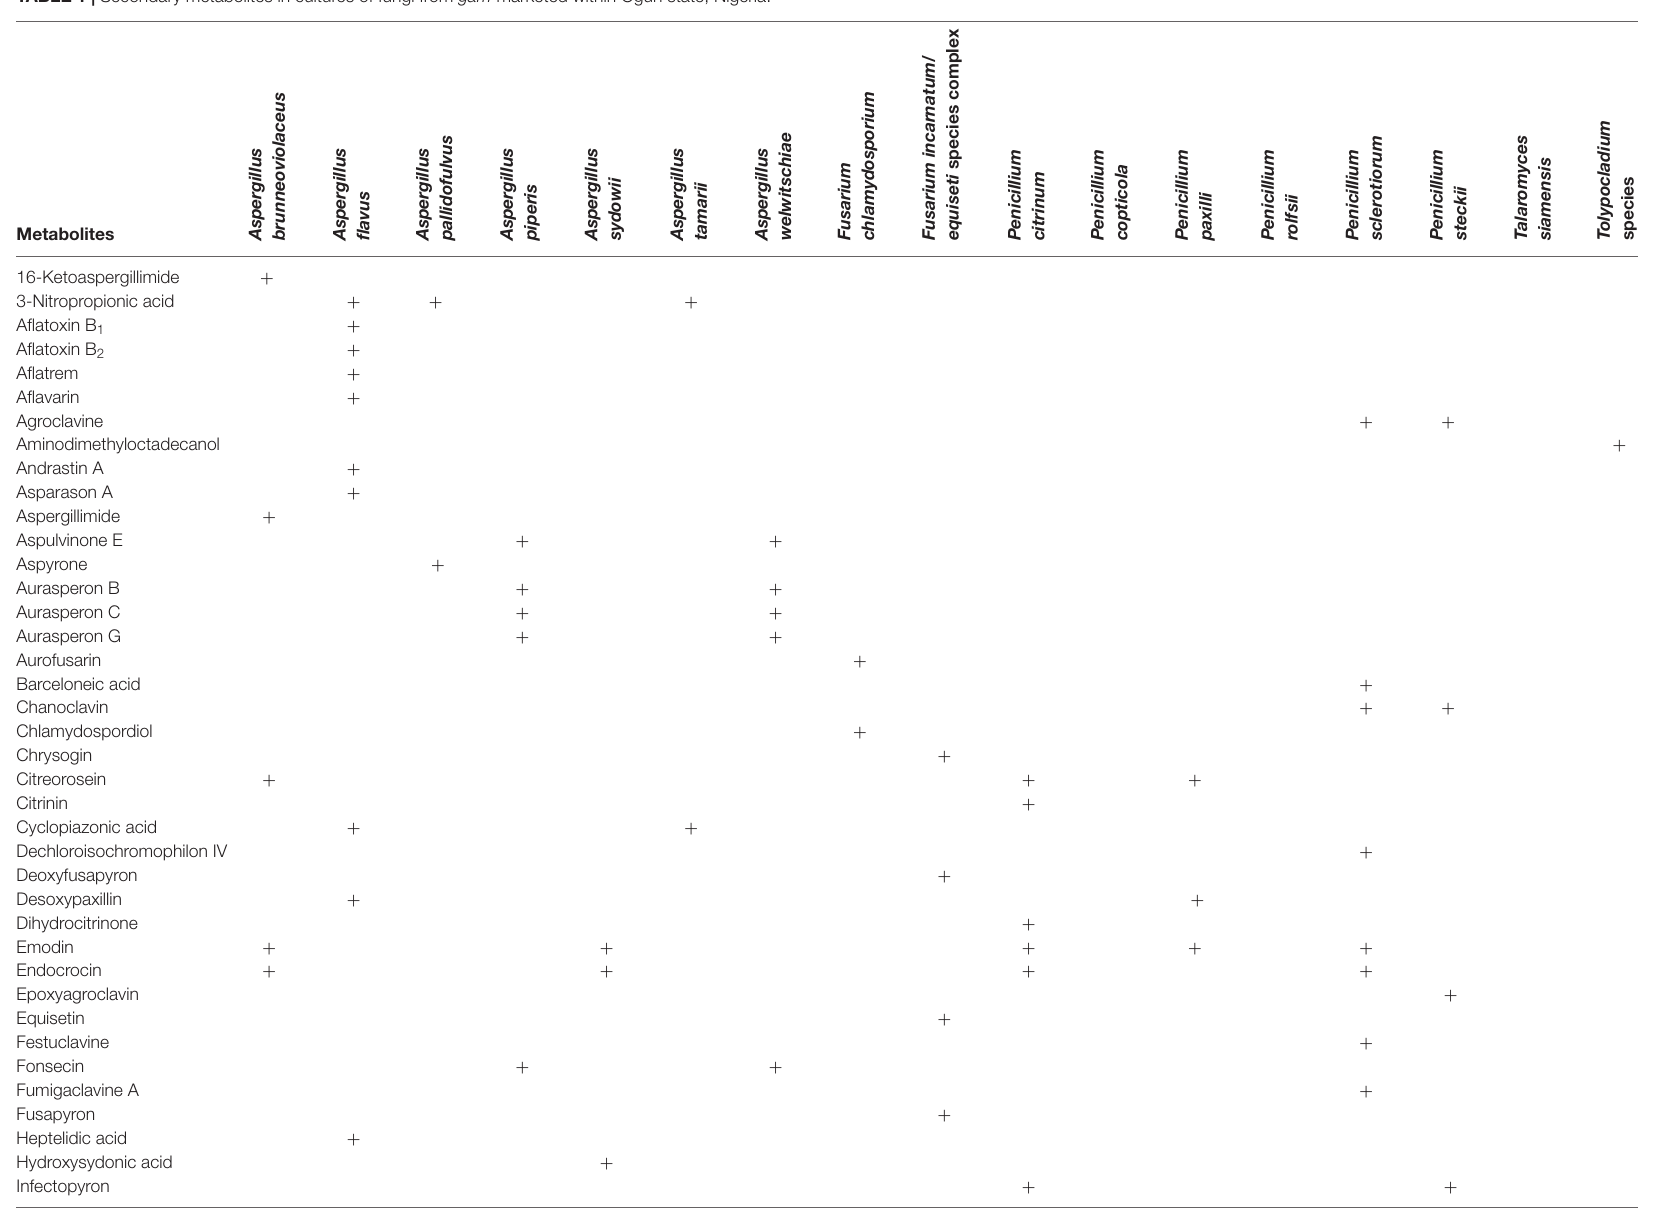
TABLE 1 | Secondary metabolites in cultures of fungi from garri marketed within Ogun state,